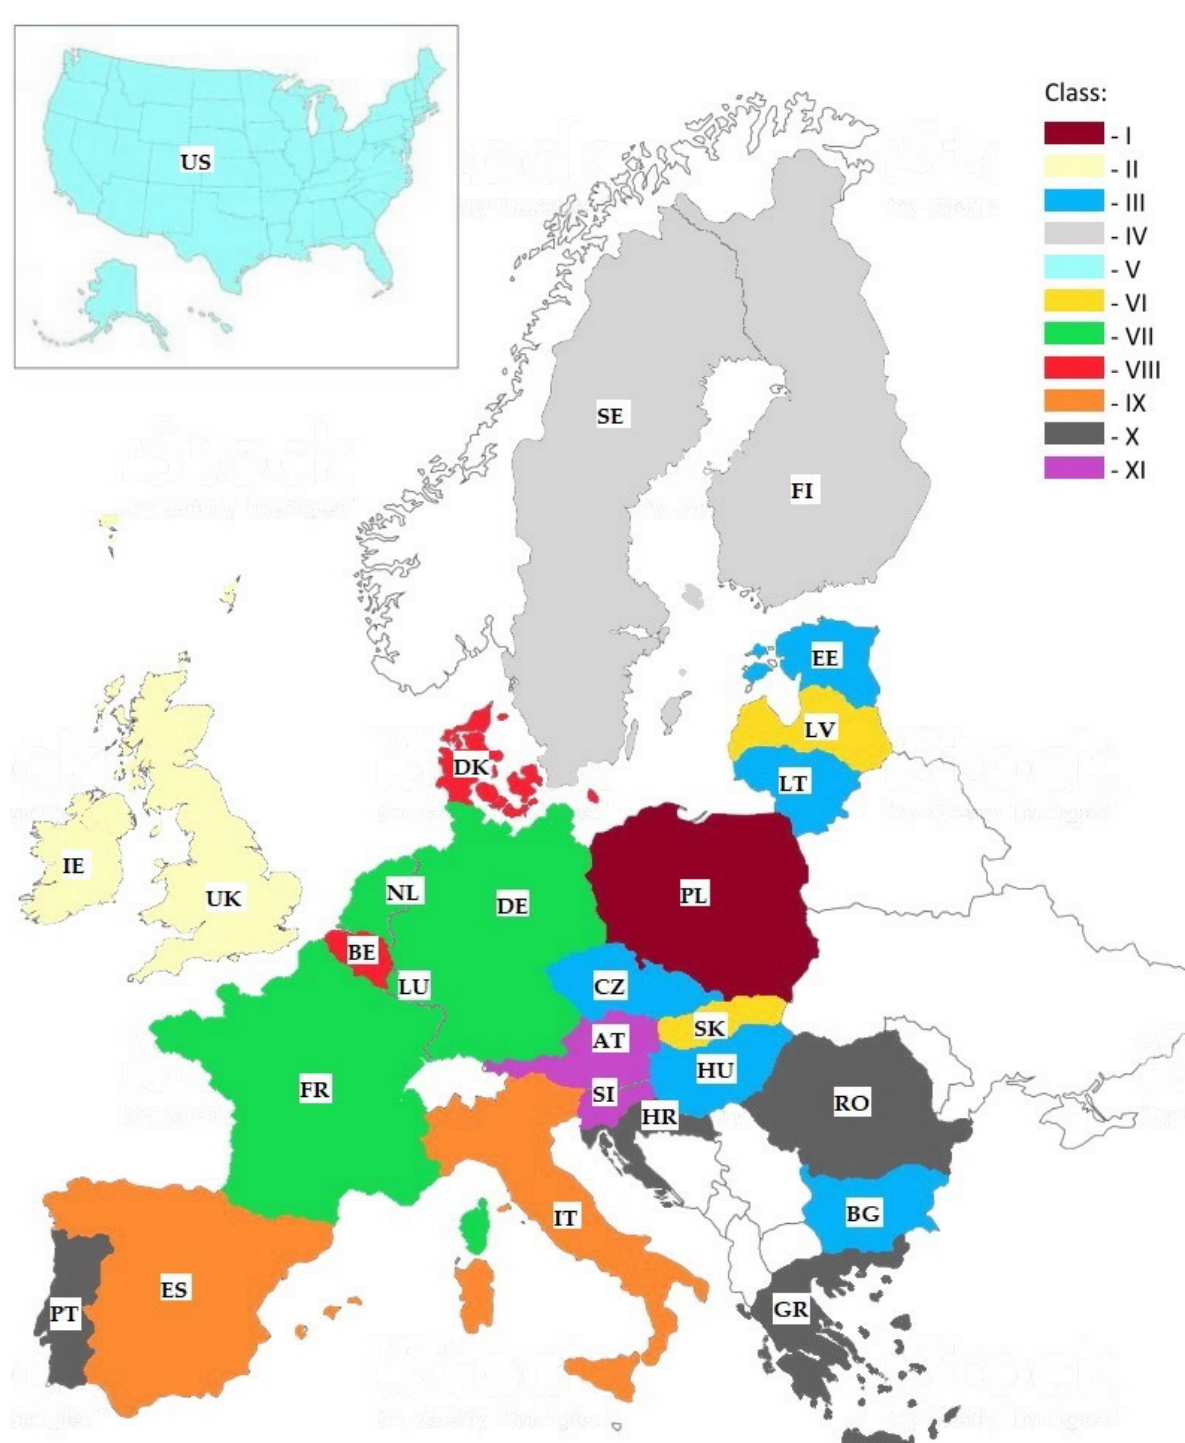
Figure 3. Typology of the EU countries and the USA depending on the production potential of the agricultural sector (Ward’s method, Euclidean distance). Note: Austria (AT), Belgium (BE), Bulgaria (BG), Croatia (HR), Czechia (CZ), Denmark (DK), Estonia (EE), Finland (FI), France (FR), Germany (DE), Greece (GR), Hungary (HU), Ireland (IE), Italy (IT), Latvia (LV), Lithuania (LT), Luxembourg (LU), Netherlands (NL), Poland (PL), Portugal (PT), Romania (RO), Slovakia (SK), Slovenia (SI), Spain (ES), Sweden (SE), United Kingdom (UK), USA (US). Source: The authors’ calculations based on [58–63].